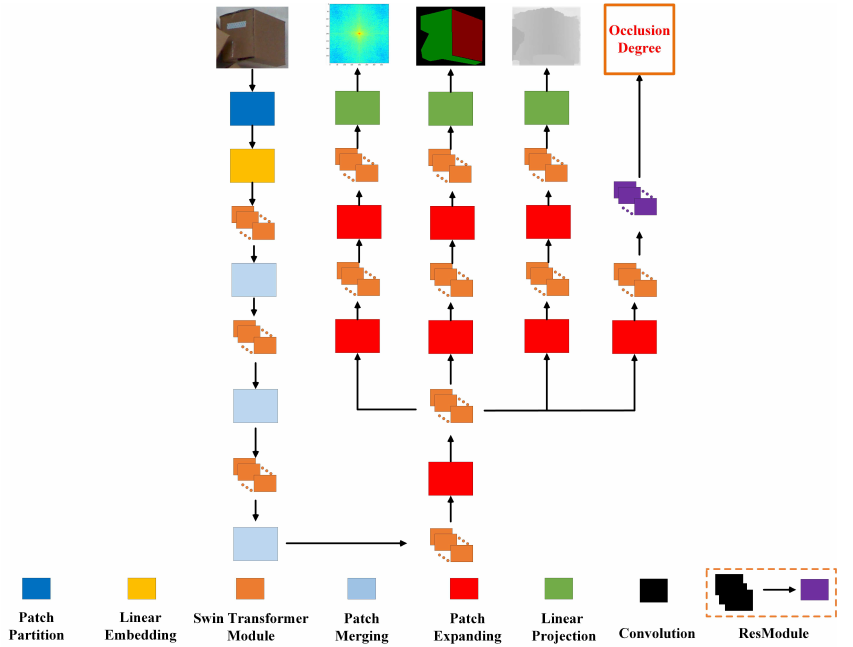
Figure 5. The overall framework of MS-ST, using multi-modal supervision branches to estimate the depth image and spectrum